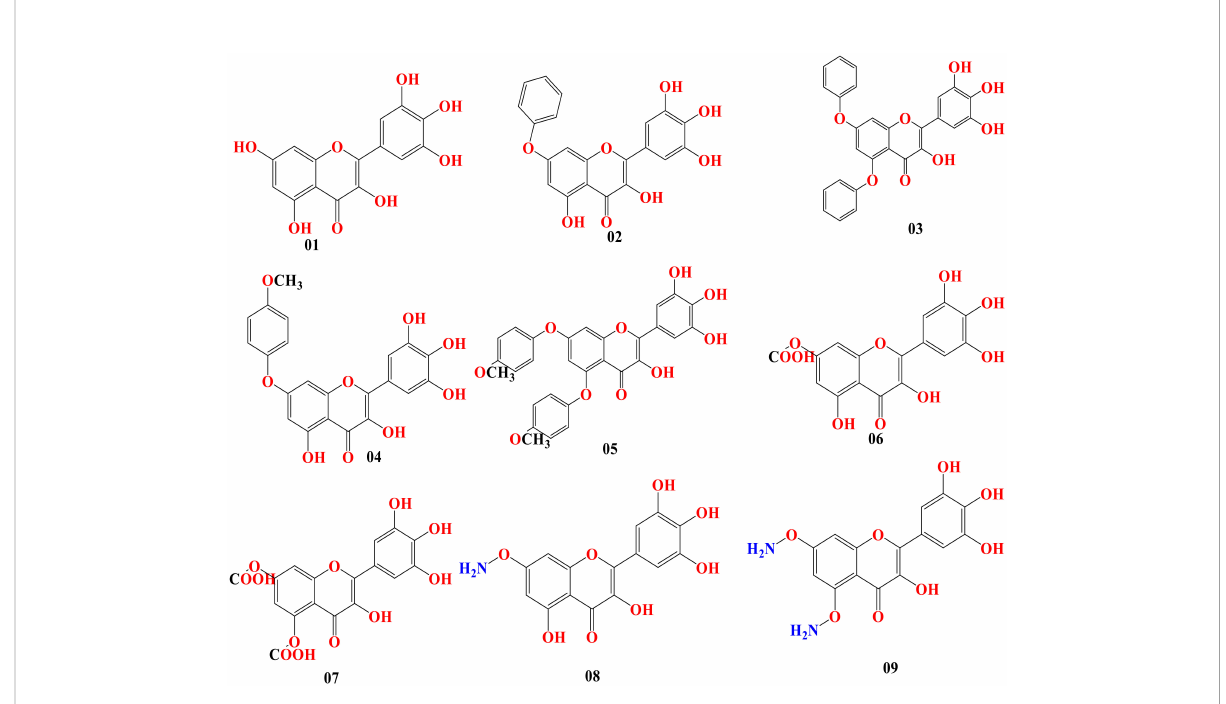
FIGURE 4 Chemical structure of myricetin and its